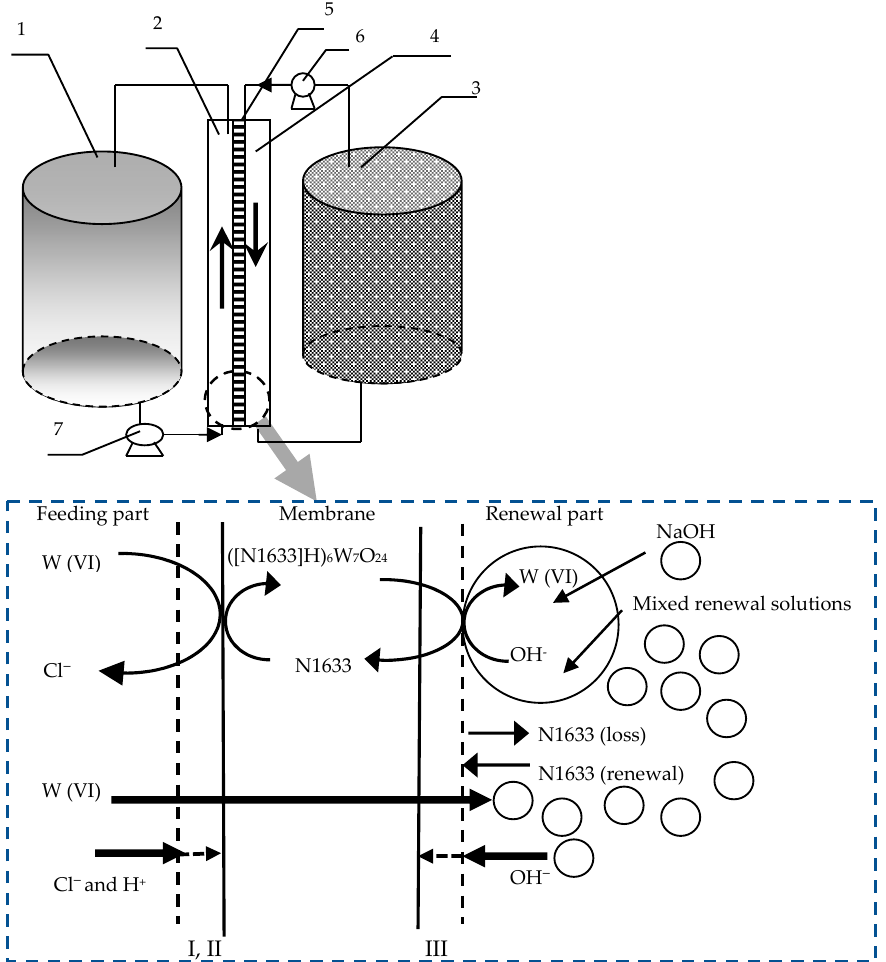
Figure 1. The structure and reaction mechanisms of the flat renewal membrane reactor (FRMR) with a mixture of N1633 dissolved in kerosene and NaOH solvent.